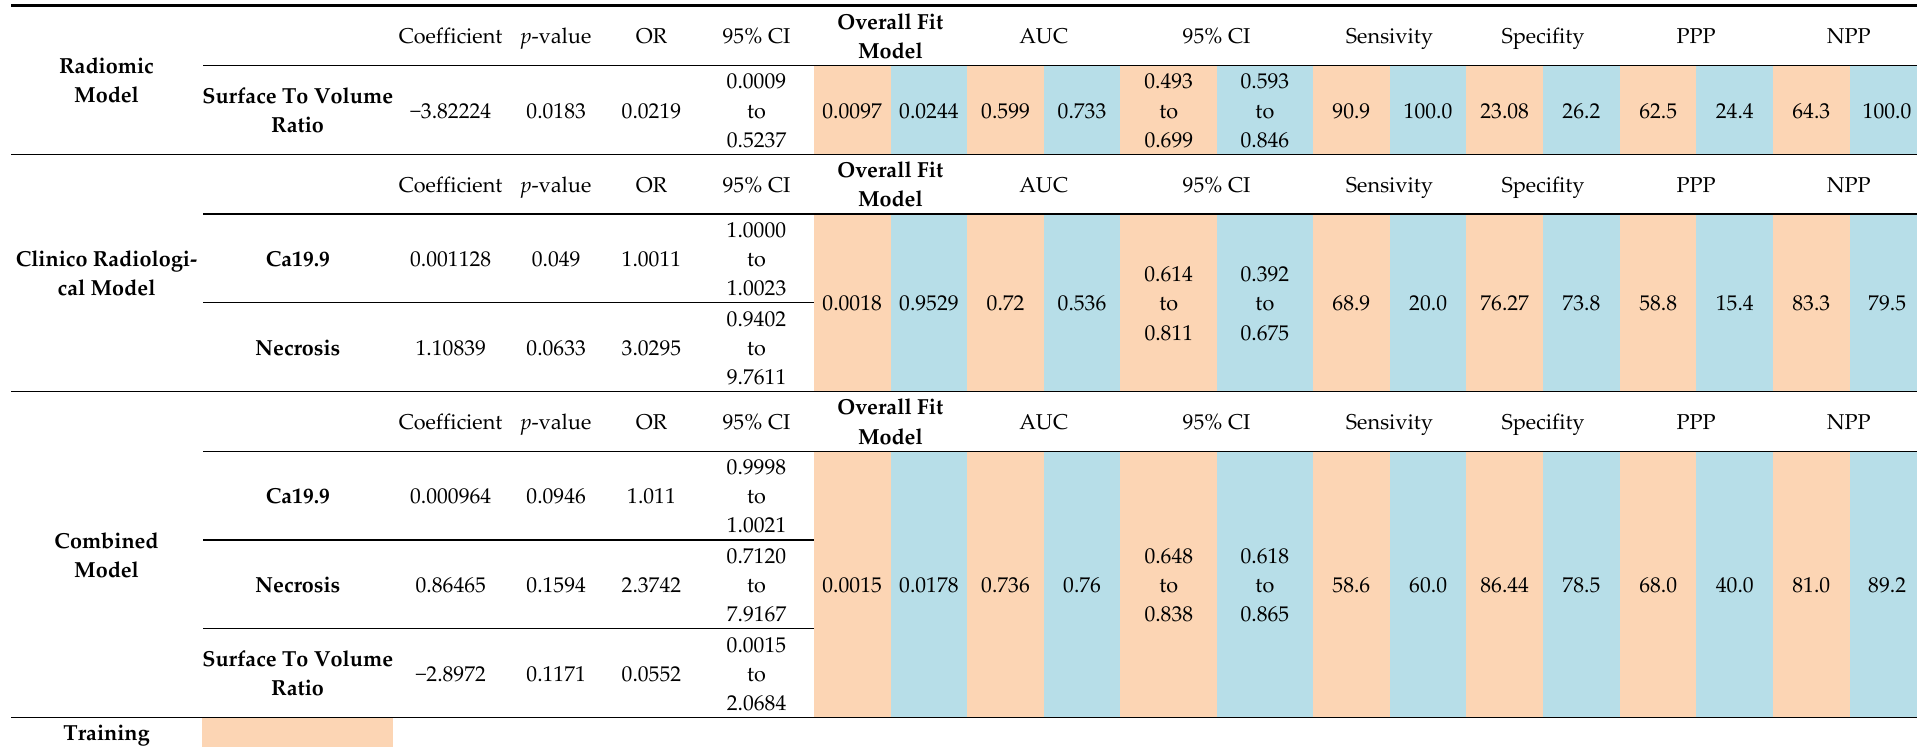
Table 2. Overall performance in both training and validation cohorts of radiomic, clinicoradiological and combined models quantified in terms of area under the ROC curve (AUC), positive and negative predictive values (PPV, NPV), specificity and sensitivity. OR: Odds Ratio, CI: Confidence Interval.